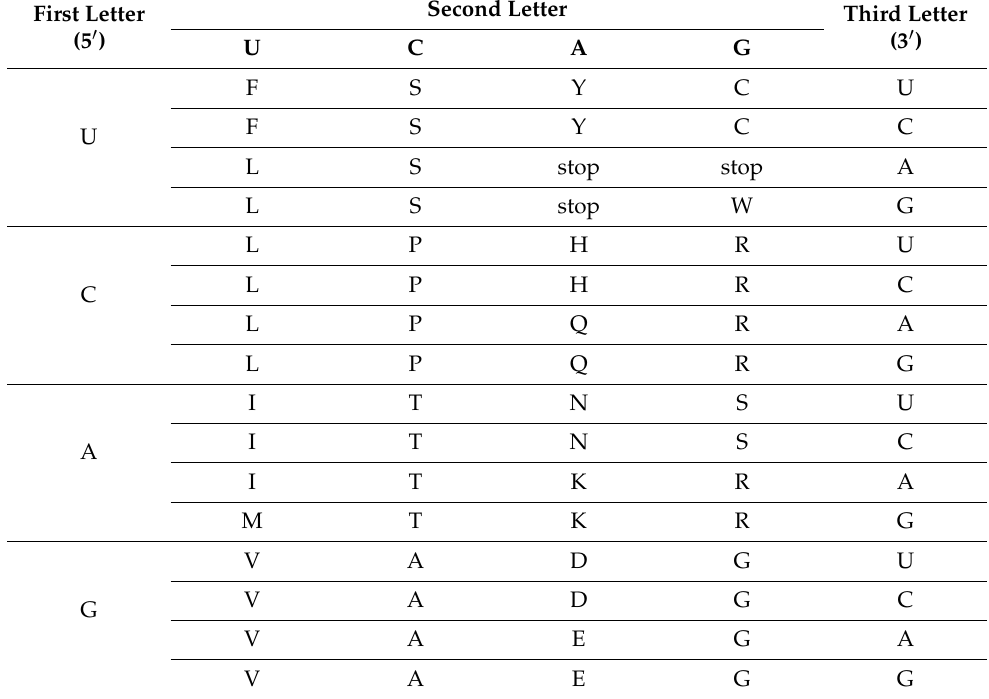
Table 1. Standard genetic code table.